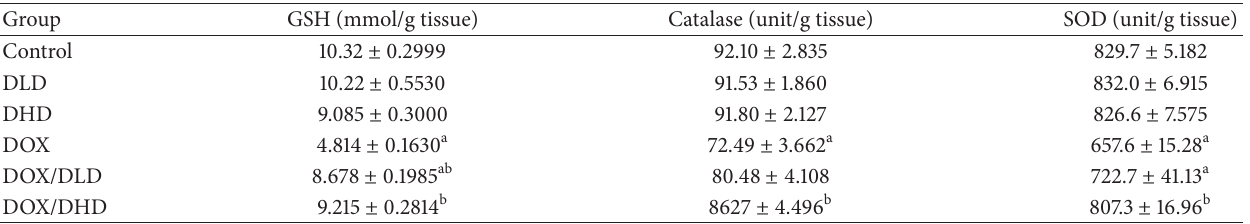
Table 2: Effect of DLD (25 mg/kg/day) and DHD (50 mg/kg/day) on GSH, catalase, and SOD in DOX (15 mg/kg) induced nephrotoxicity.